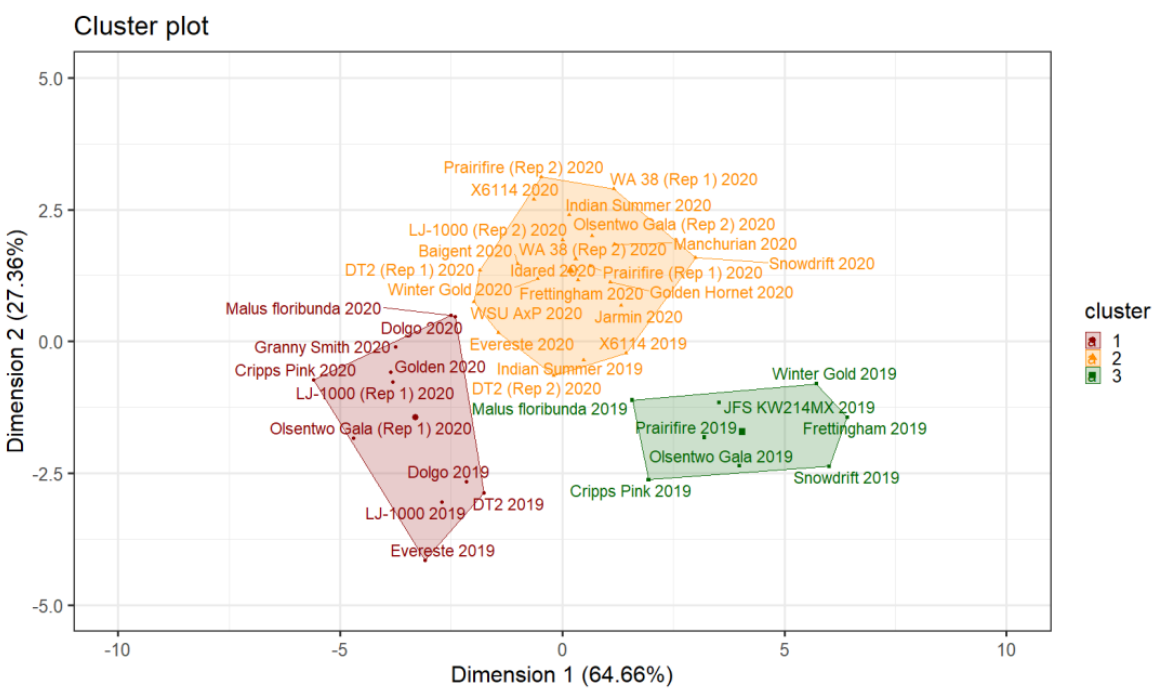
Figure 5. Final partitioning using K-means clustering. Projections are shown on the first and second dimensions, which explains the 92% total variance. Individuals are color-coded based on their cluster membership (cluster 1 = red, cluster 2 = yellow, cluster 3 = green).